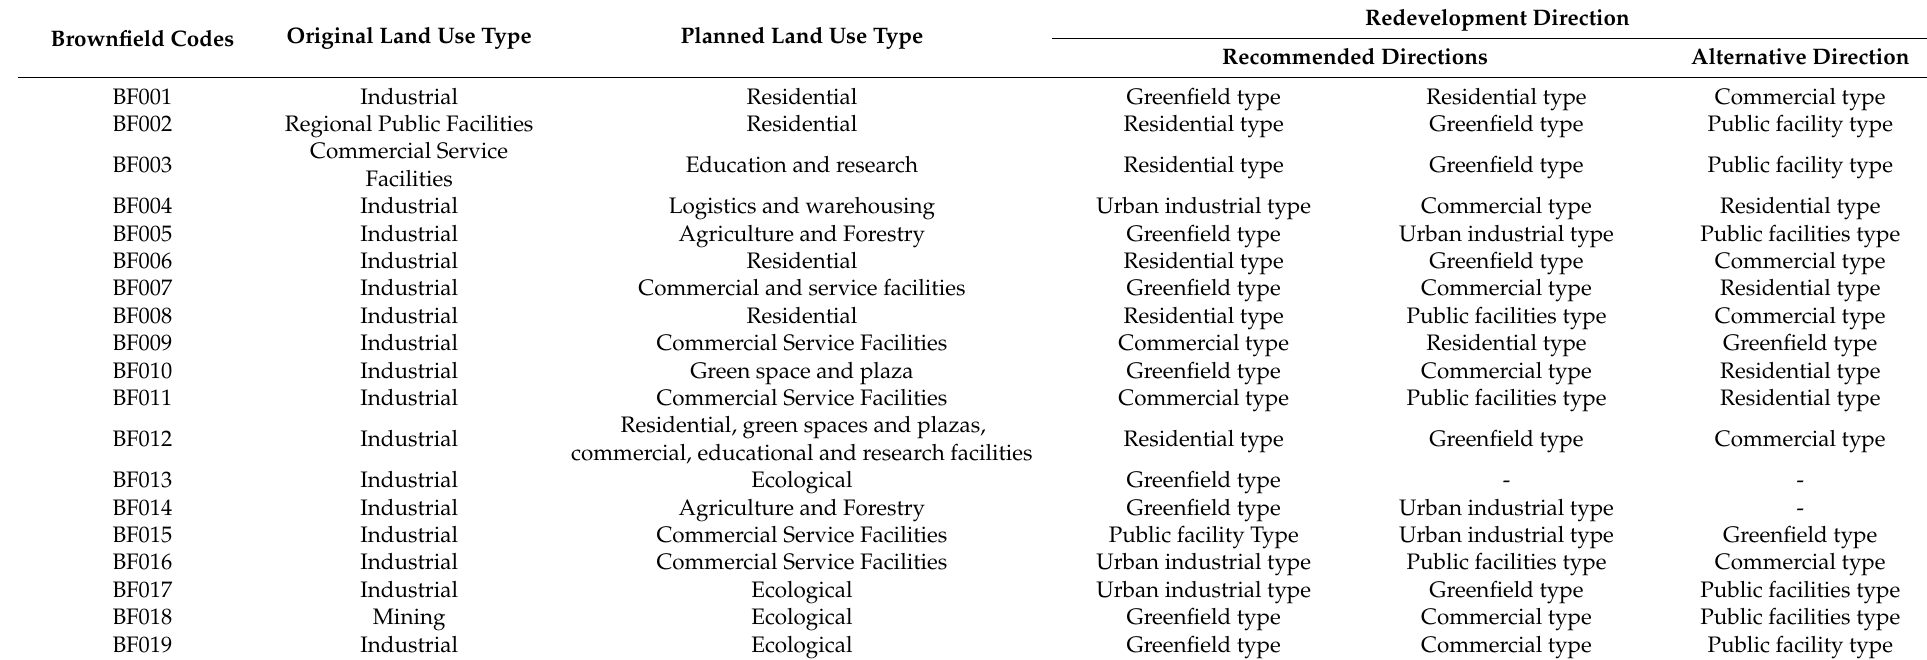
Table 6. Screening values and control values for the risk of heavy metal contamination of soil on construction